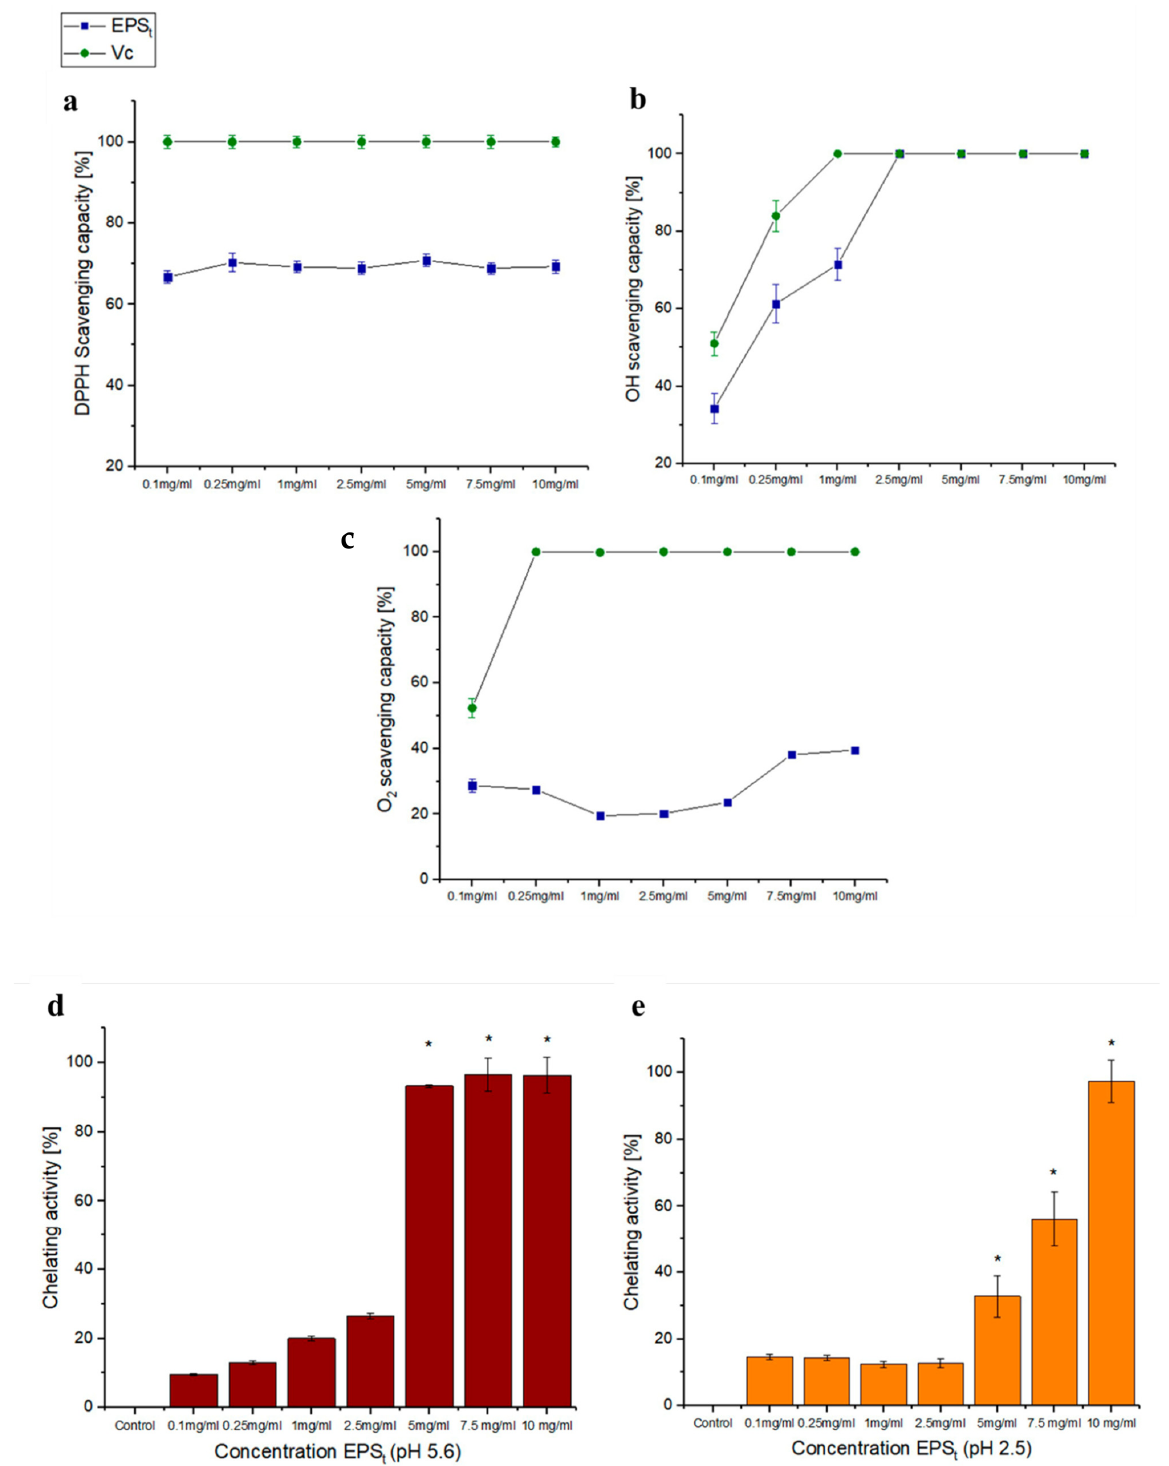
Figure 6. Antioxidant tests in vitro with different concentrations of EPS t . ( a ) DPPH free radical scavenging activity of EPS t compared to that of ascorbic acid (Vc). ( b ) Hydroxyl radical scavenging activity of EPS t compared to that of ascorbic acid (Vc). ( c ) Superoxide anion scavenging activity of EPS t compared to that of ascorbic acid (Vc). ( d ) EPS t chelating activity at different concentrations measured at pH 5.6. ( e ) EPS t chelating activity at different concentrations measured at pH 2.5. (n = 3, significant differences * p < 0.05).